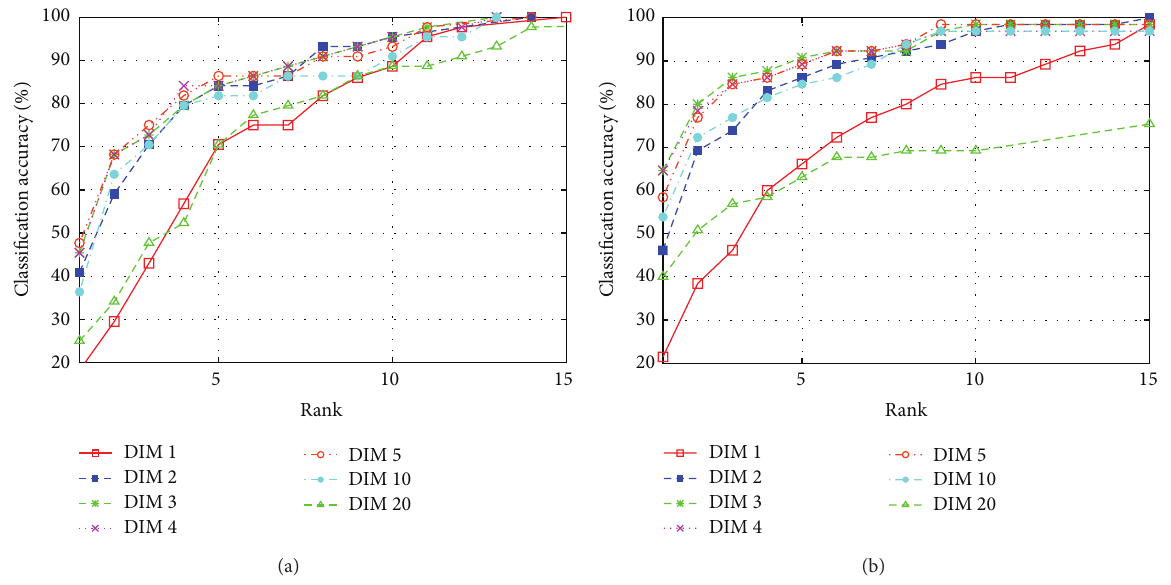
Figure 9: Cumulative match characteristic curves for rank based classification accuracies. (a) MIT-BIH arrhythmia database and (b) IIT (BHU)